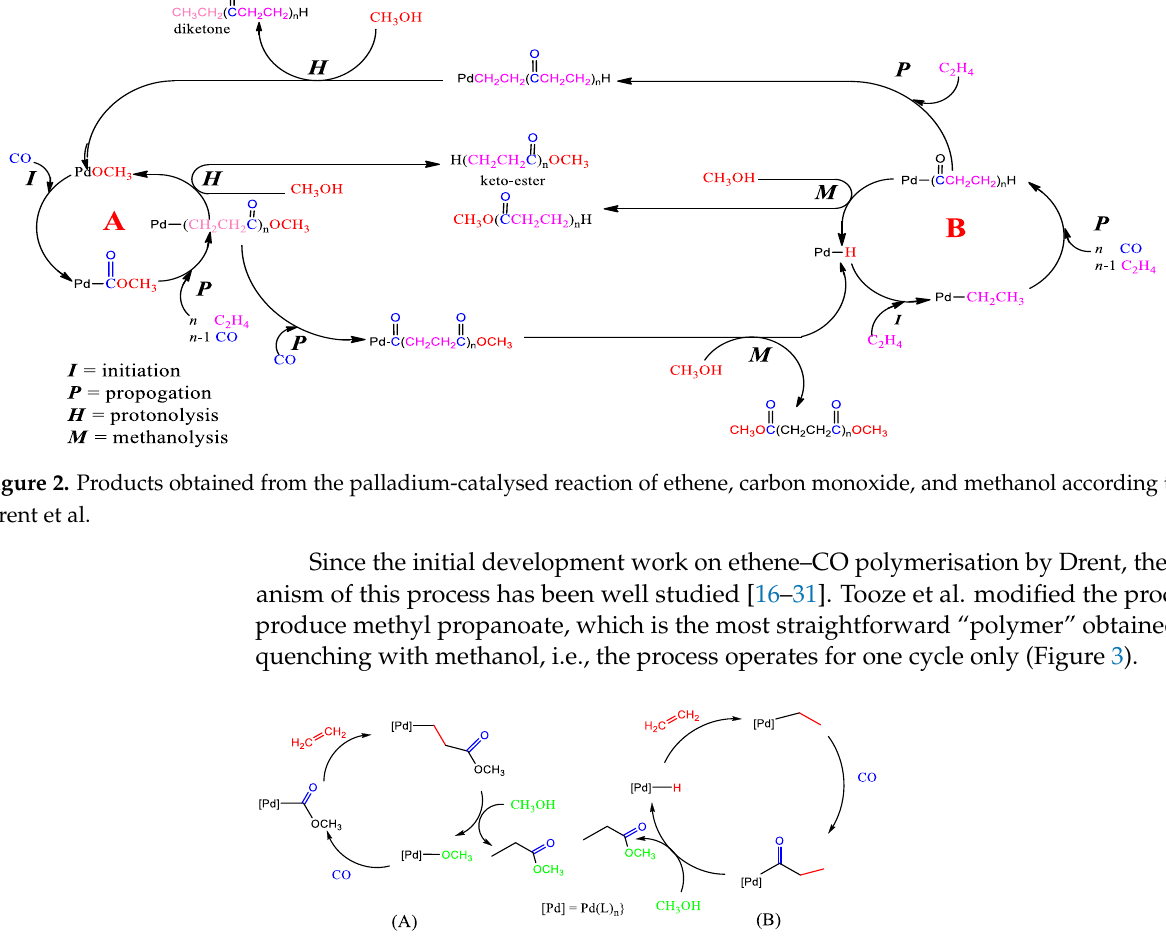
Figure 3. ( A ) Simplified carbomethoxy cycle and ( B ) simplified hydride cycle to methyl propan- oate formation